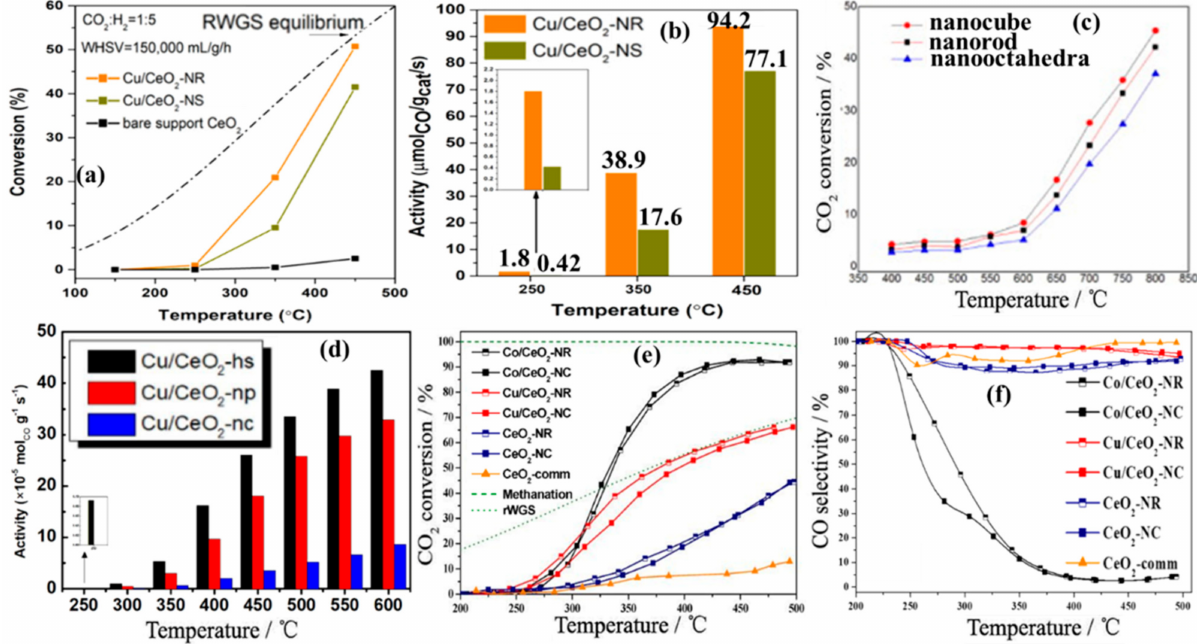
Figure 10. Effect of shape and crystal face on metal-CeO 2 RWGS reaction: ( a,b ) Cu − CeO 2 , reprinted with permission from [81]. Copyright ACS, 2018, ( c ) CeO 2 , reprinted with permission from [83]. Copyright Elsevier, 2016, ( d ) Cu − CeO 2 , reprinted with permission from [88]. Copyright